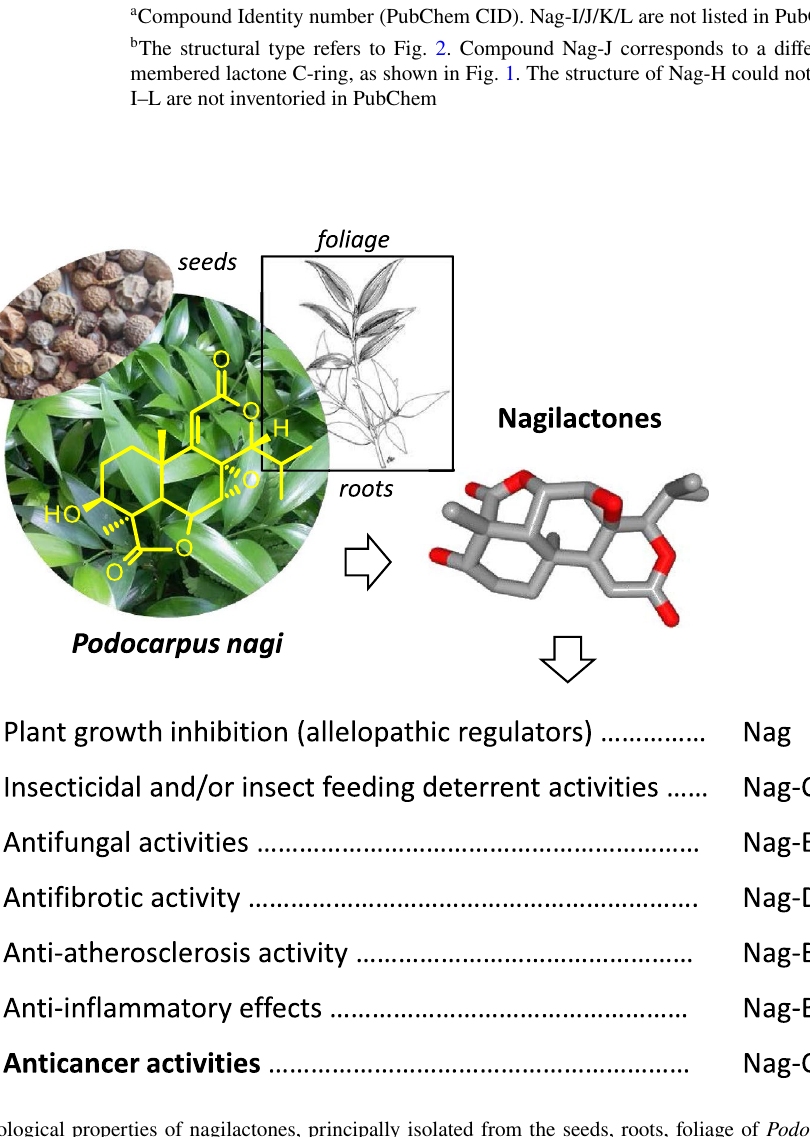
Fig. 3 The various biological properties of nagilactones, principally isolated from the seeds, roots, foliage of Podocarpus nagi [67] and other Podocarpus